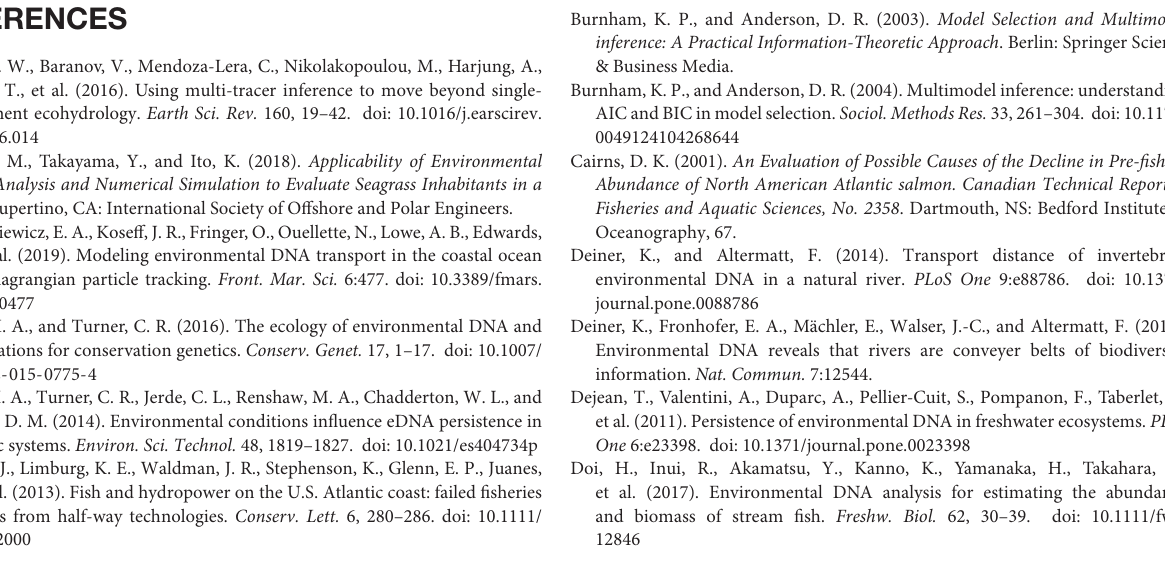
Supplementary Figure 1 | eDNA detection rate versus downstream distance from fish, separated for midstream and bankside samples. Supplementary Figure 2 | Receiver Operating Characteristic (ROC) diagnostic curve for predicted eDNA detection. Gray line indicates null (random classifier) expectation. Supplementary Figure 3 | AIC versus theoretical maximum eDNA proportion at banks downstream from fish ( P max ) for the full and reduced dataset. The reduced dataset excludes distances > 1,600 m, which were not sampled for all streams. Even lateral eDNA dispersion across a stream (i.e., across one midstream and both bankside samples) would result in an optimum P max value of 0.67. Supplementary Figure 4 | Number of samples necessary for 95% chance of salmon detection downstream from a target reach. Optimal sampling is roughly 1,000 m downstream of fish at banks and immediately downstream of fish in the midstream. Optimal sample numbers for fish detection decreases with increasing numbers of fish and decreasing velocity (V). Low, med, and high V indicate 0.15, 0.35, and 0.55 m/s, respectively. Predictions here are shown for 5% quantile detectability stream (i.e., low detectability). Supplementary Figure 5 | Salmon detection rate based on uniform sample spacing. Optimal sample spacing for fish detection increases with increasing numbers of fish and decreasing velocity (V). Low, med, and high V indicate 0.15, 0.35, and 0.55 m/s, respectively. Detection rate assumes three independent technical replicates. Predictions here are shown for 5% quantile detectability stream (i.e., low detectability). Fish were simulated in a 100 km-long stream and detection rates estimated from uniform sample spacing. Supplementary Table 1 | Formulas for four eDNA dispersal models. Supplementary Table 2 | Comparison of four eDNA dispersal models with and without samples > 1,600 m downstream